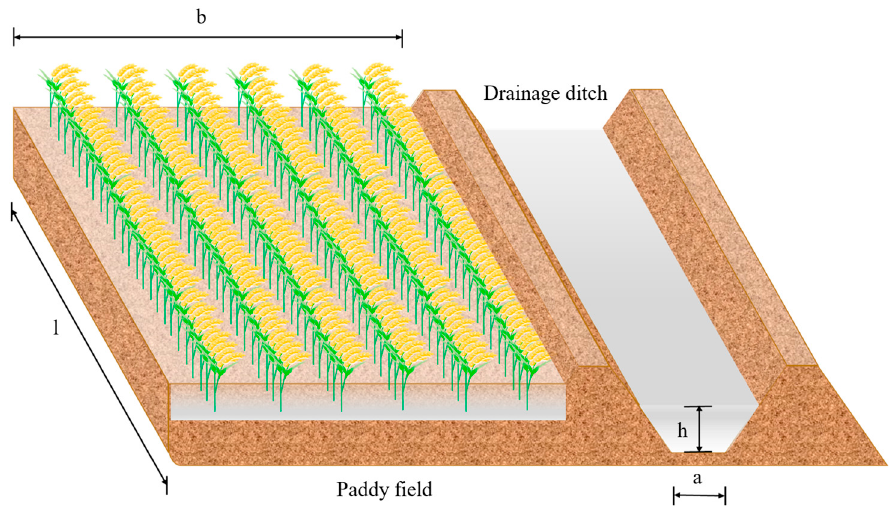
Figure 3. The traditional drainage engineering layout of the paddy field.